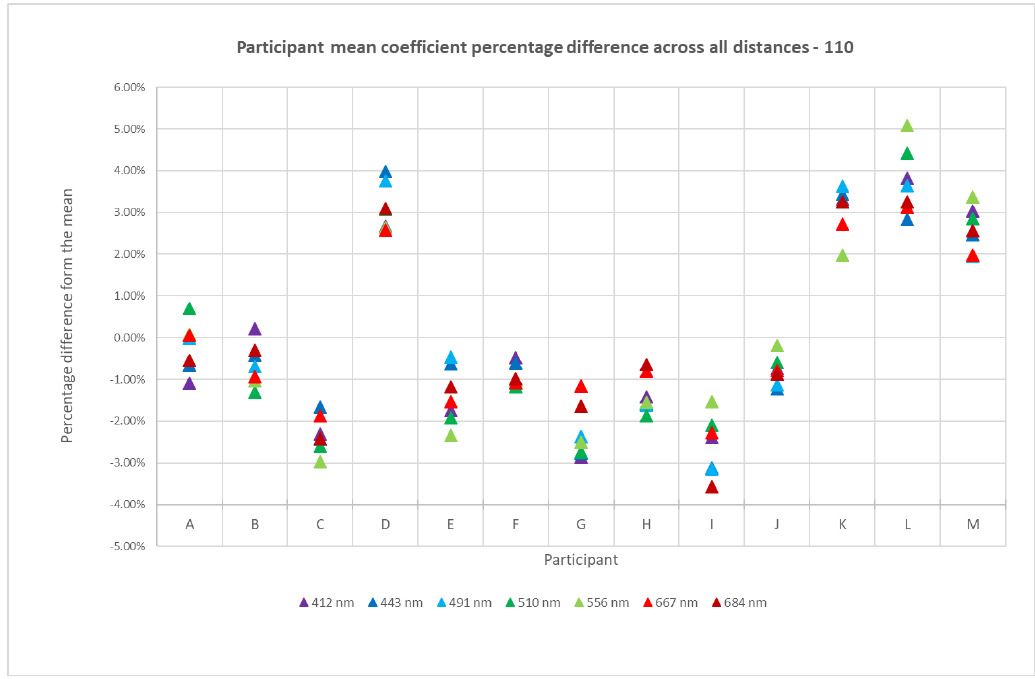
Figure 6. Results of the radiance comparison for radiometer 110. Radiance calibration coefficient compared to mean calibration coefficient for each participant/set-up at each